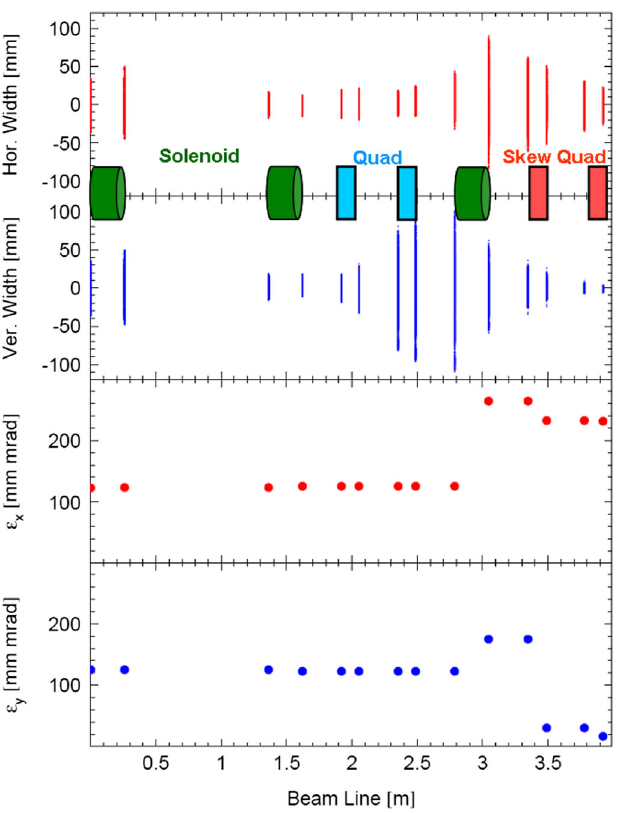
FIG. 5. Two-dimensional projections of the ECR transverse phase space distribution at the exit of the emittance transfer section. Horizontal and vertical rms Twiss parameters are in- dicated as well as the four interplane correlation parameters.